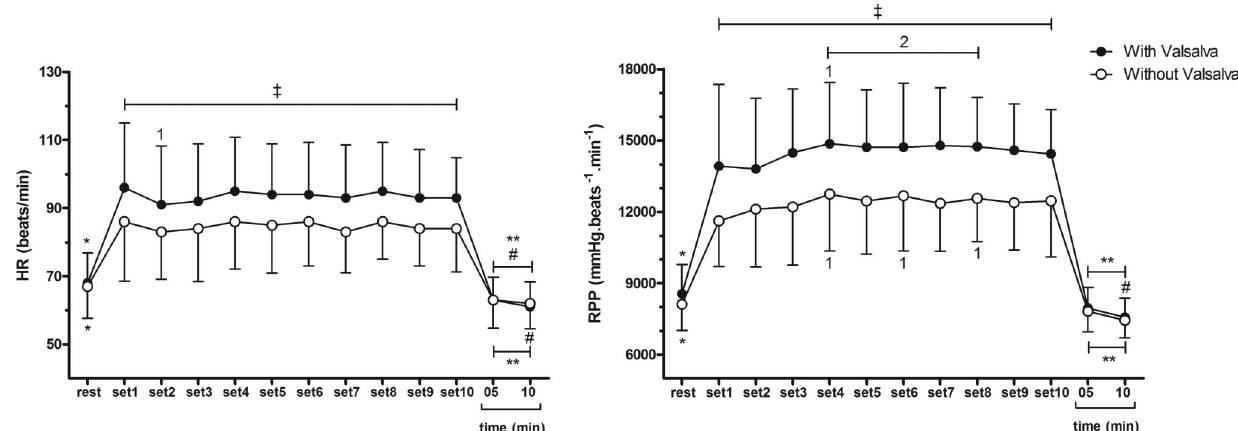
Figure 3 - Heart rate (HR) and rate pressure product (RPP) at rest, during stretching protocols performed with and without the Valsalva maneuver, and at 10 min post-exercise. Superscripted numbers represent significant differences vs . the indicated set. * : Significant difference between the resting condition and all sets ( p o 0.05). ** : Significant difference between post-exercise assessments and all sets ( p o 0.05). = : Significant difference between sets in protocols performed with the VM vs. without the VM ( p o